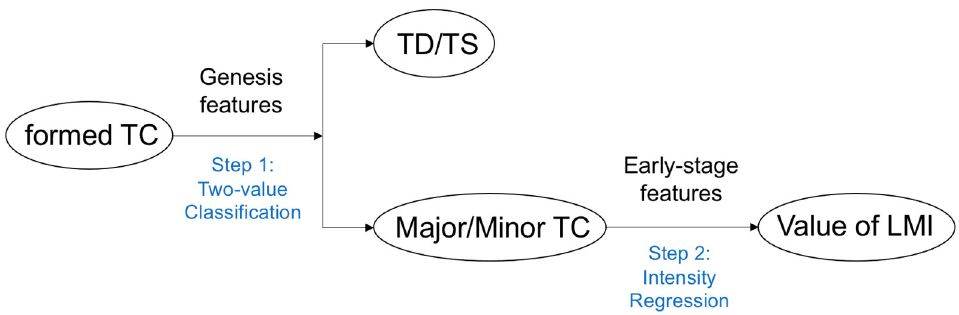
Figure 4. Flow diagram of two-step LMI analysis in this study. TD/TS is also called weak TC and major/minor TCs are collectively named strong TCs.